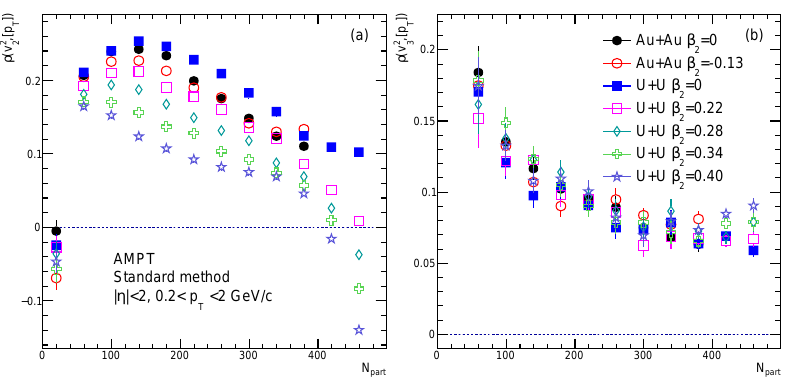
(cid:0) ] (cid:1) for v 2 , [ p T n